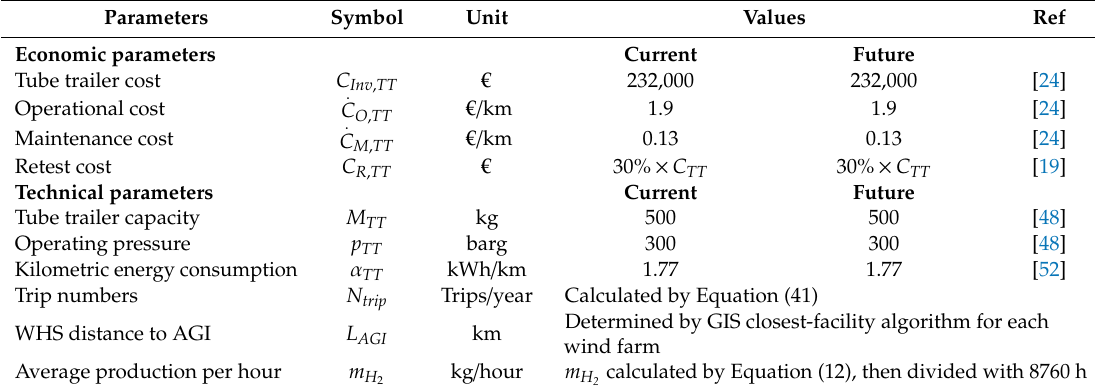
Table 3. Techno-economic parameters in the transportation submodel.